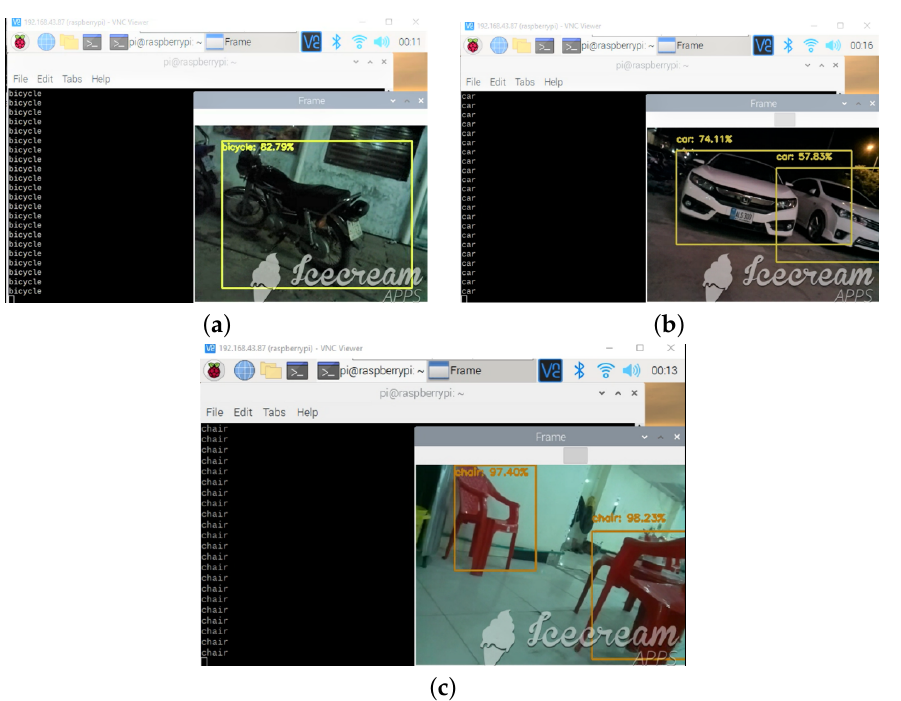
Figure 13. ( a ) Motorcycle detected using OpenCV; ( b ) Cars detected using OpenCV; ( c ) Chairs detected using